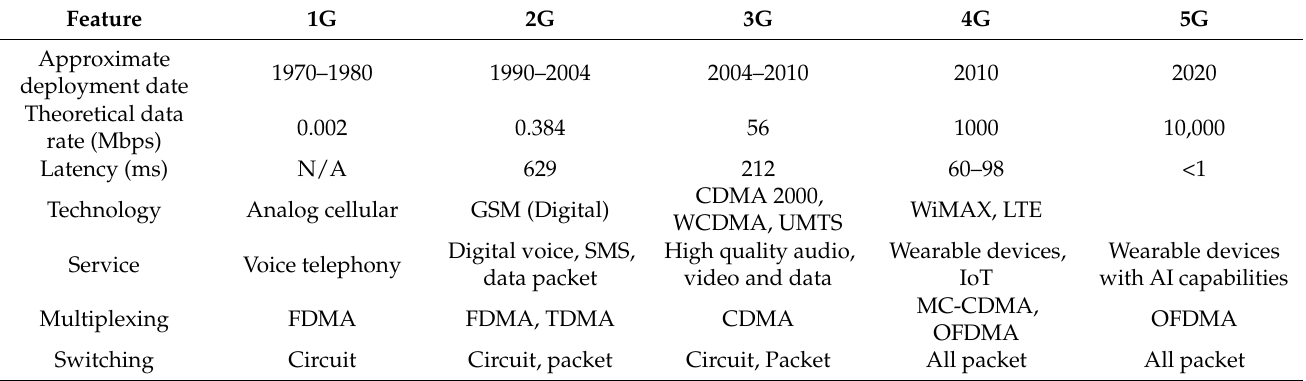
Table 4. The Evolution of Mobile Networks